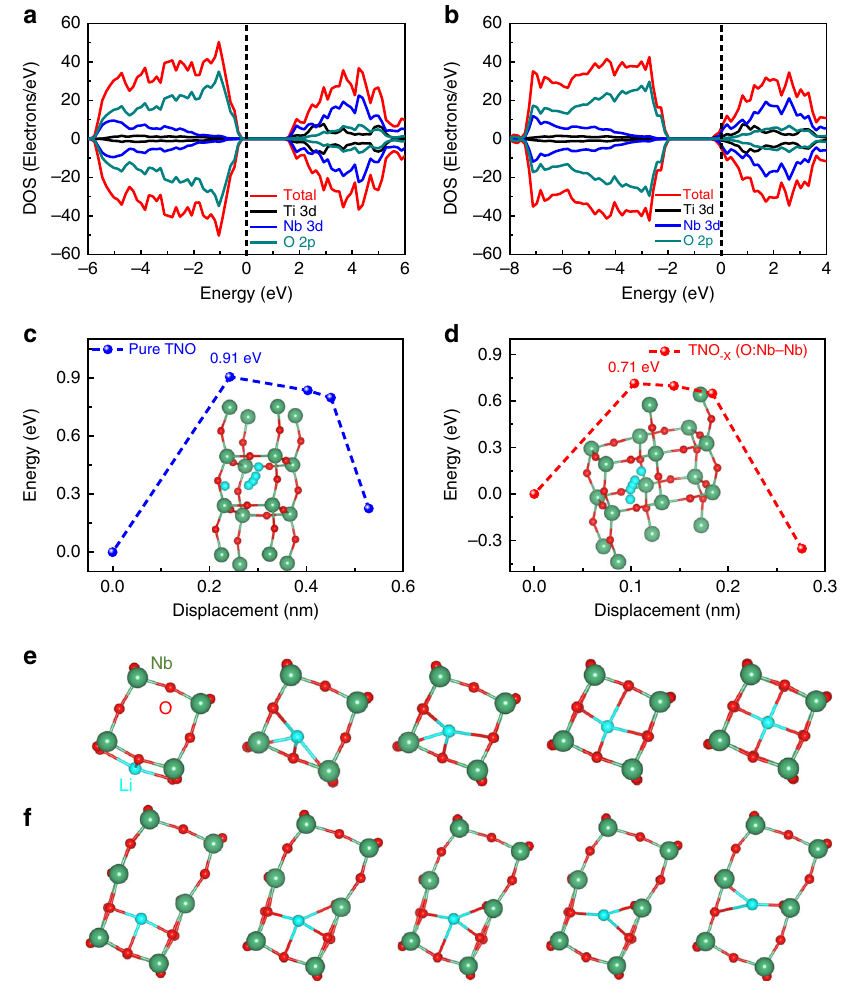
Fig. 4 Density of states (DOS) of pure TNO and defective TNO − x . a DOS of pure TNO. b DOS of defective TNO − x (O:Ti – Nb). c The Li ion diffusion energy barrier for TNO. d The Li ion diffusion energy barrier for TNO − x (O:Nb – Nb). e The Li ion diffusion pathways for TNO. f The Li ion diffusion pathways for TNO − x (O:Nb –